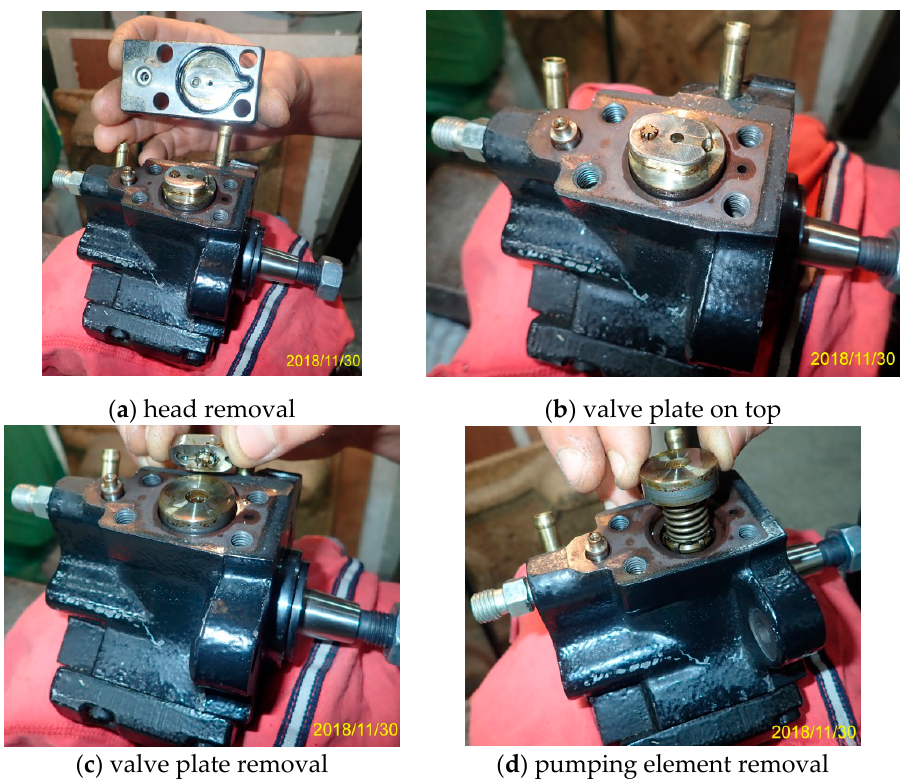
Figure 6. Disassembly steps of the common-rail high-pressure pump: removal of head, valve plate, and pumping element.